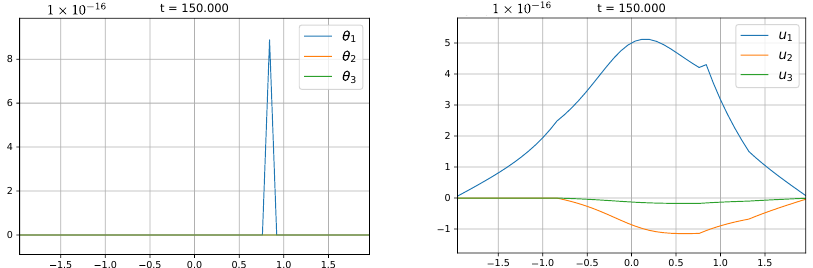
Figure 9. Difference between the numerical solution at t = 100 s and the exact steady state solution for the relative density θ α ( left ) and velocities ( right